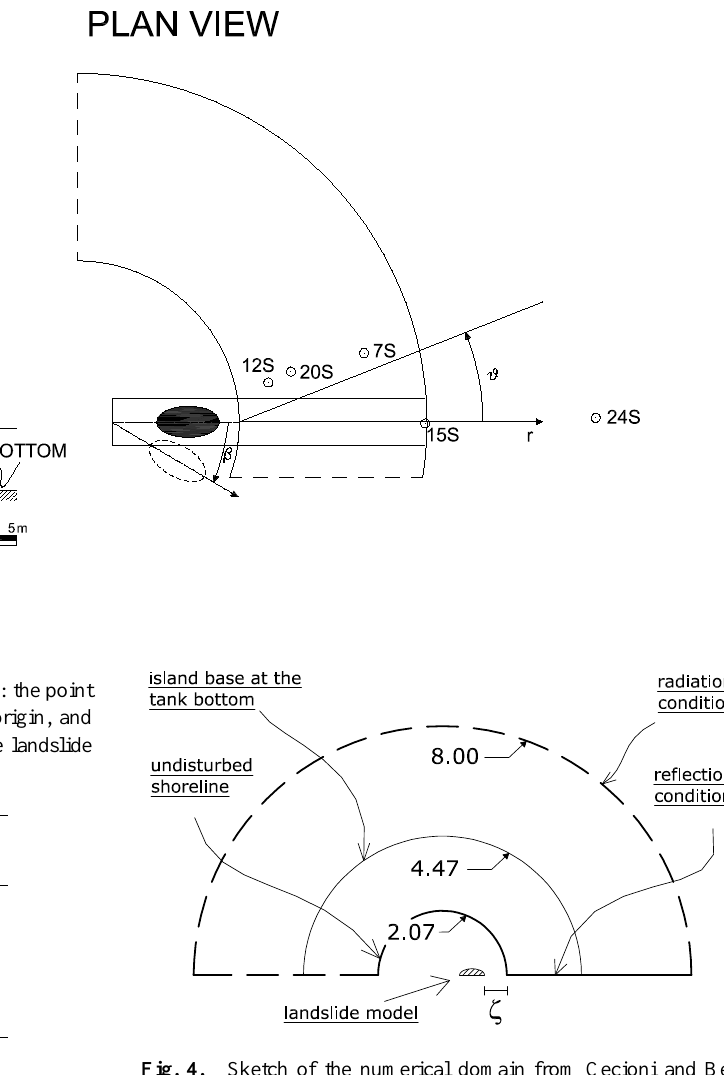
Fig. 4. Sketch of the numerical domain from Cecioni and Bel- lotti (2010b). The numbers 2.07, 4.47 and 8.00 express the radii in metres of the undisturbed shoreline, the island base at the tank bottom, and the external circular boundary,